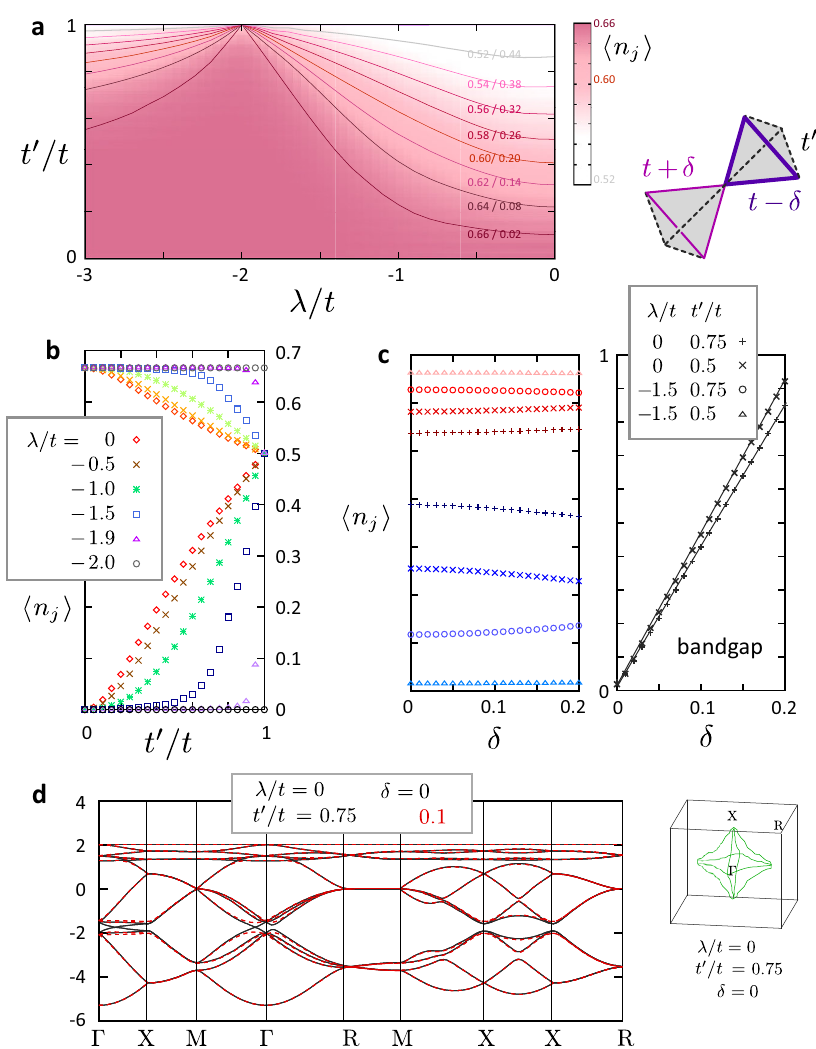
Fig. 4 Examination of the effect of lattice distortions: U = V = 0 and the transfer integrals being modi fi ed for t ! t 0 ; t ± δ . a Charge density 〈 n 〉 = 〈 n + n 〉 for δ = 0 on the plane of λ / t and t 0 = t . Contour lines with charge rich/poor densities are drawn. b, c 〈 n j j ↑ j ↓ panel is the band gap for δ ≥ 0 when t 0 = t ¼ 0 : 75 and 0.5. d Band structures for λ = 0 with t 0 = t ¼ 0 : 75 comparing the cases with δ = 0 (solid) and 0.1 (broken line). Right panel is the Fermi surface for the δ = 0